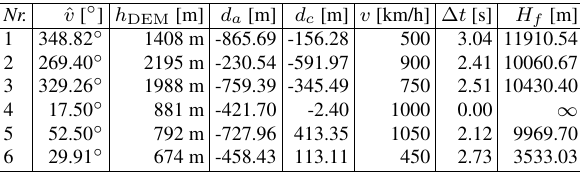
Table 3: Plane measurements in RapidEye image, ˆ v is the head- ing of the plane in degree (north=0, east=90, ...),